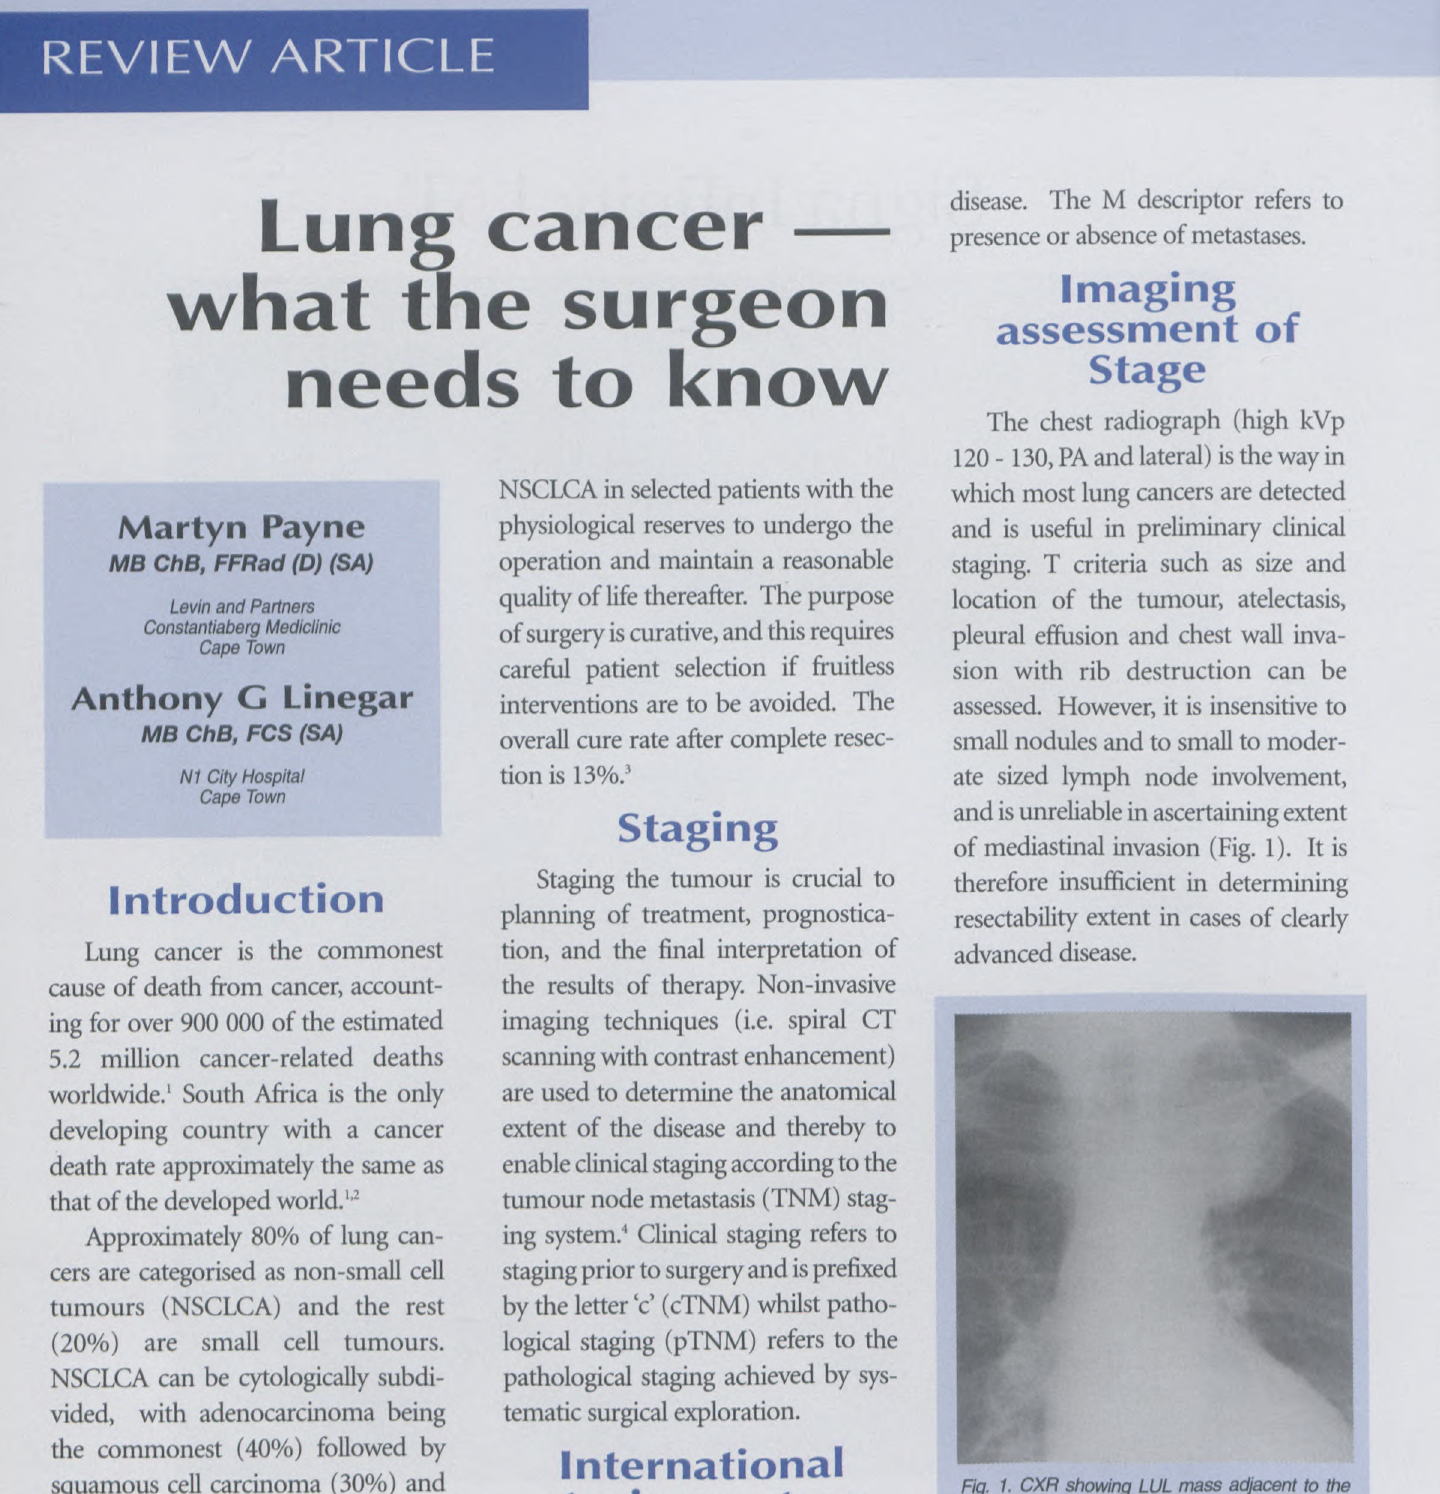
Fig. 1. CXR showing LUL mass adjacent to the mediastinum. Invasion cannot be assessed. Surgically proven resectable